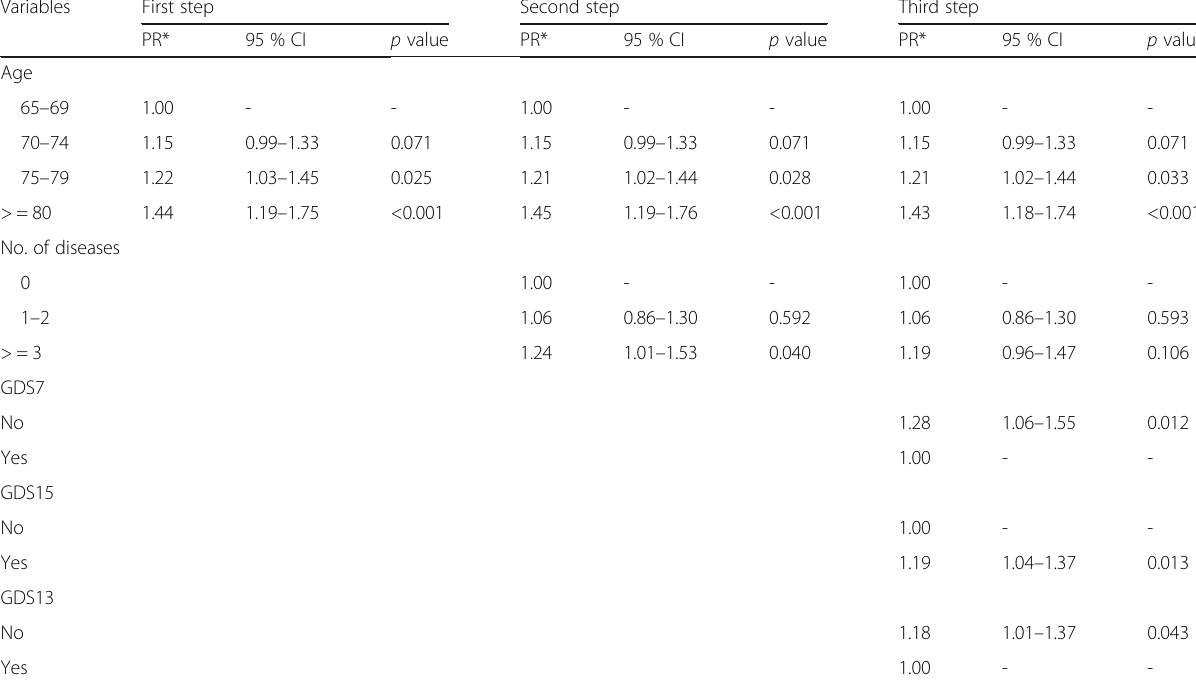
Table 5 Hierarchical model with multivariate Poisson regression for pre-frailty ( n = 1931). FIBRA Unicamp, Elderly, 2008 – 2009